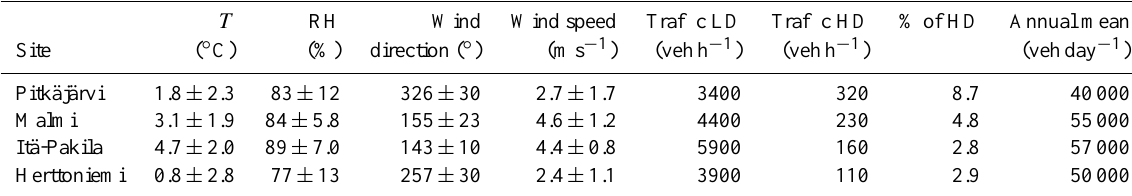
Table 1. Average of hourly meteorological conditions as recorded by the HSY at the Ämmässuo site, representing the regional air mass properties. The traffic LD and HD data are based on the manual 3min observations, and the annual mean traffic flow per day by the Finnish Transport